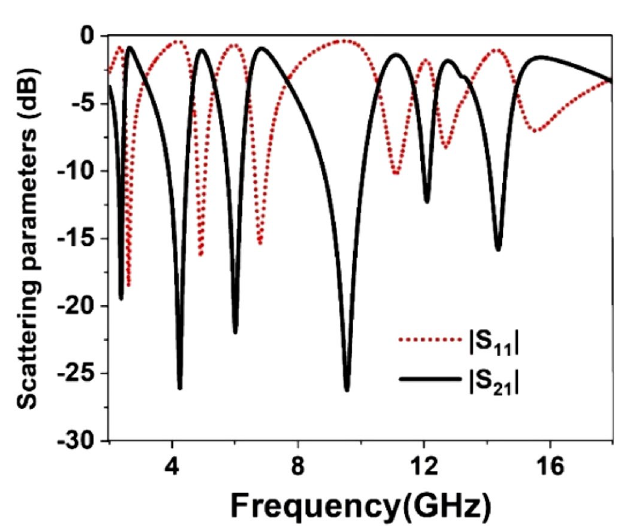
Figure 18. Surface current distribution at copper backplane of the resonator ( a ) 3.98 GHz ( b ) 5.5 GHz ( c ) 8.48 GHz and ( d ) 11.73 GHz.